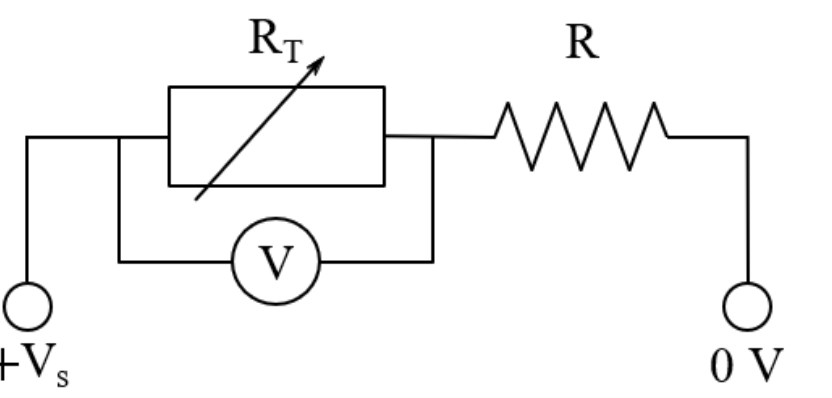
Figure 24. Thermistor as part of a potential divider for voltage measurement by the microcontroller.